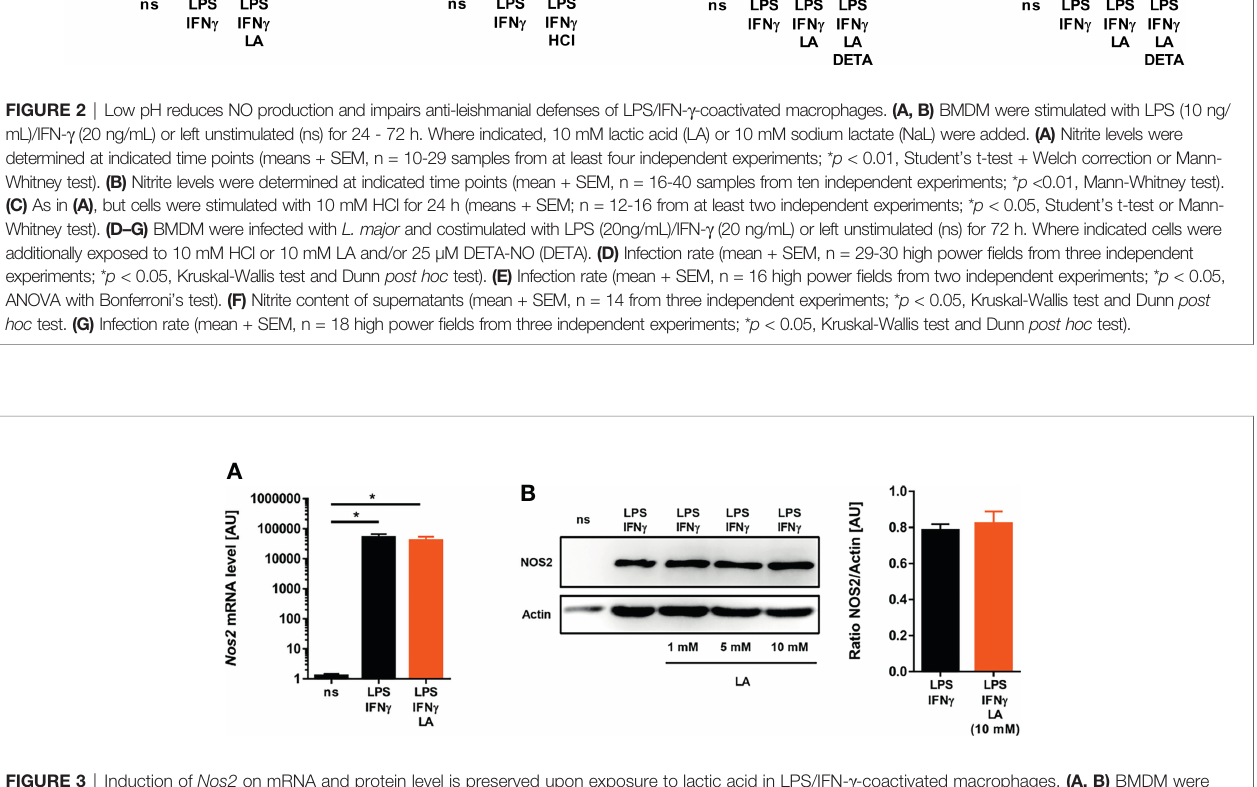
FIGURE 3 | Induction of Nos2 on mRNA and protein level is preserved upon exposure to lactic acid in LPS/IFN- g -coactivated macrophages. (A, B) BMDM were costimulated with LPS (10 ng/mL)/IFN- g (20 ng/mL) or left unstimulated (ns) for 24 h. Cells were treated with 10 mM lactic acid (LA), unless indicated otherwise. (A) Nos2 mRNA levels (mean + SEM, n = 14-15 samples from fi ve independent experiments; * p < 0.05, Kruskal-Wallis test and Dunn post hoc test). (B) Left panel: NOS2 and Actin protein levels (representative out of six similar independent experiments). Right panel: Densitometry of NOS2 normalized to Actin protein levels after treatment with 10 mM LA (mean + SEM, n = 6 from six independent experiments; Student ’ s t